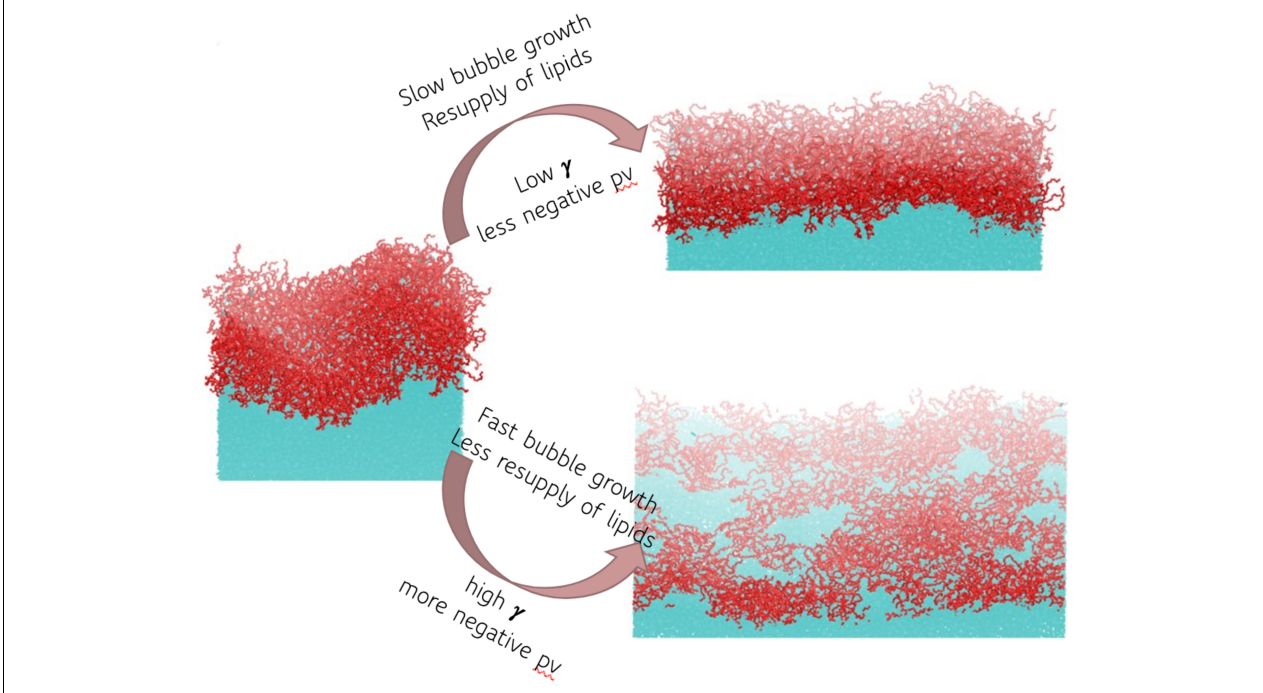
FIGURE 4 | Schematic representation of the effect of pressure and bubble growth rate on monolayer structure, and hence surface tension γ . Red atoms are digalactosyldiacylglycerol (DGDG), cyan are